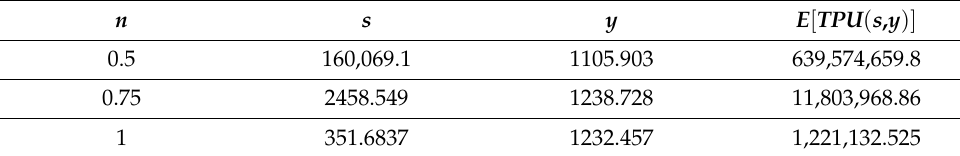
Table 3. Optimal solution for Example 3 for n = {0.5,0.75,1}.